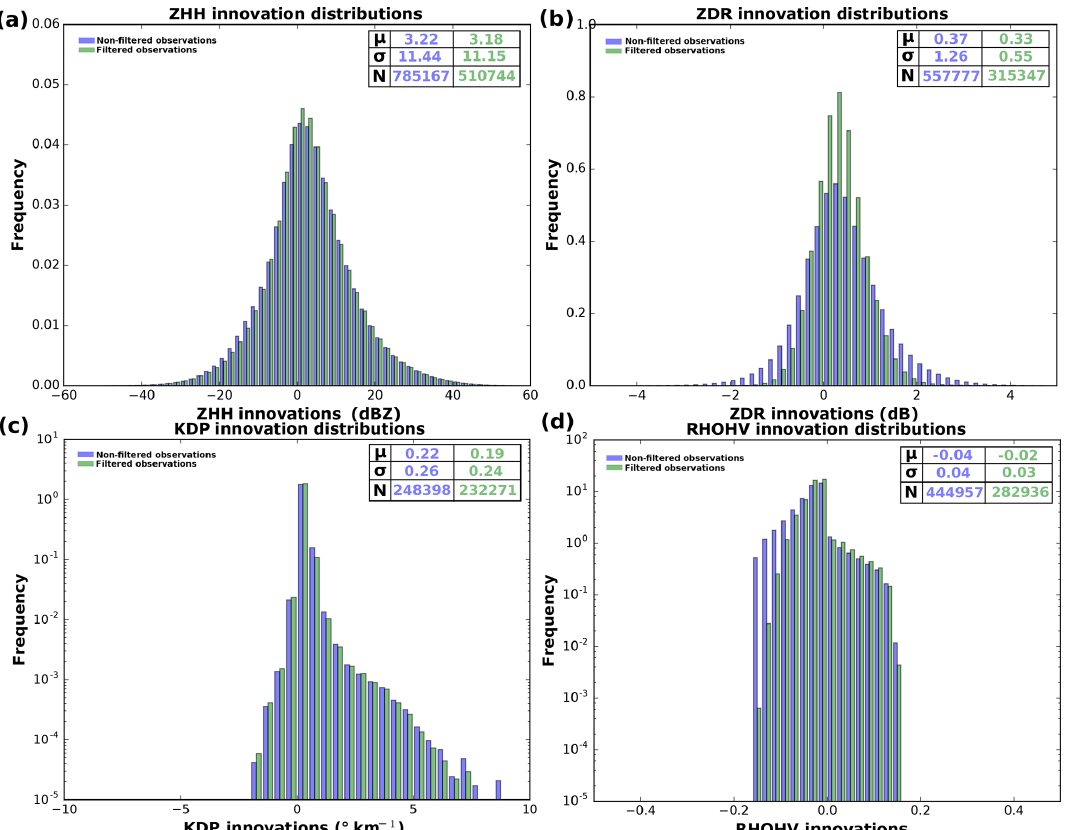
Figure 5. Innovations without (blue histograms) and with (green histograms) filters on observations for (a) Z HH , (b) Z DR , (c) K DP and (d) ρ HV . µ represents the innovation bias, σ the innovation standard deviation and N the sample